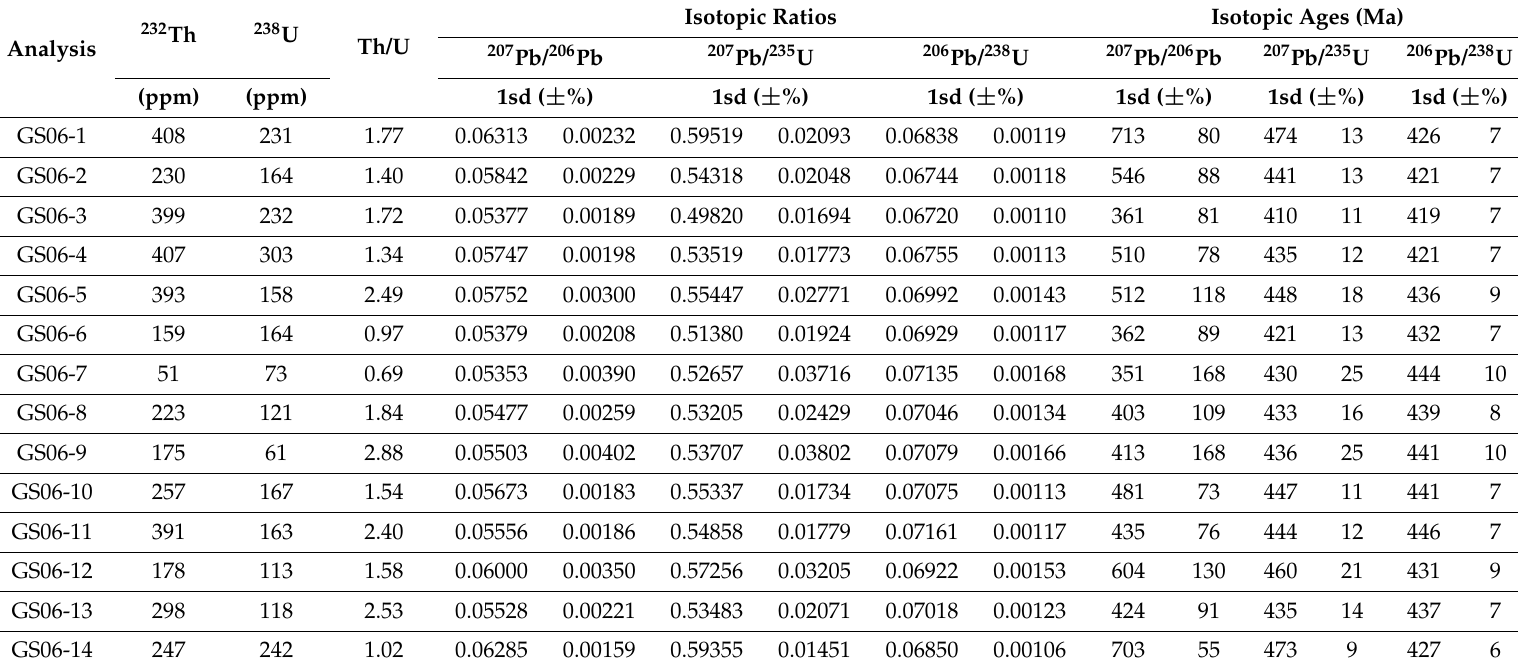
Table 6. Results of zircon U-Pb age analysis of the mafic enclaves in the Qingshanbao